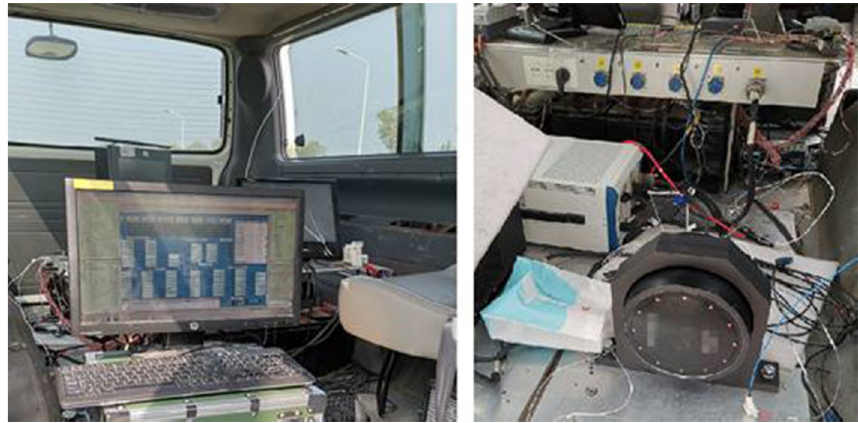
Figure 6. SINS/BDS integrated navigation system and test